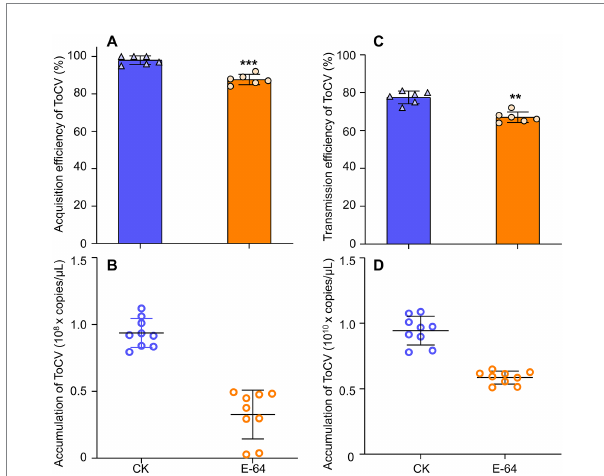
FIGURE 6 The effects of E-64 treatment on acquisition and transmission in B. tabaci MED. (A) Acquisition rate of ToCV by B. tabaci MED with E-64 treatment. (B) ToCV accumulation by B. tabaci MED with E-64 treatment. (C) Transmission rate of ToCV by B. tabaci MED with E-64 treatment. (D) ToCV accumulation of in tomato plants exposed to B. tabaci MED with E-64 treatment. CK, control; E-64, cathepsin inhibitors. Data are denoted as mean ± SE. *** indicates a significant